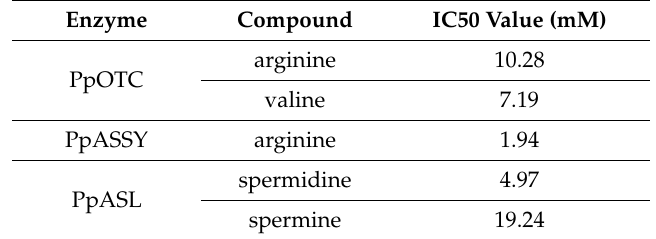
Table 2. IC50 values for PpOTC, PpASSY and PpASL activity inhibitor compounds. Enzyme Compound IC50 Value (mM) arginine PpOTC